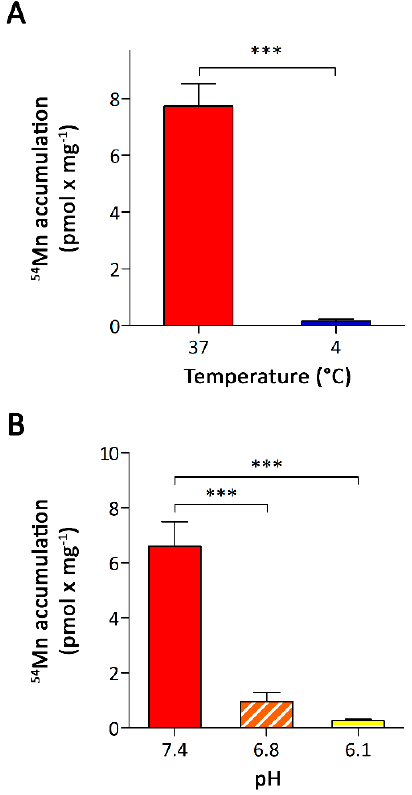
Figure 3. Effects of temperature and extracellular pH on 54 Mn accumulation by A549 cells. (A) Temperature dependence of 54 Mn accumulation and (B) dependence of 54 Mn accumulation on the extracellular pH. Data are presented as means ± SD from three independent experiments performed in duplicates. Statistical analysis was performed using (A) student’s t -test or (B) one-way ANOVA followed by the Bonferroni post-hoc test with *** p <